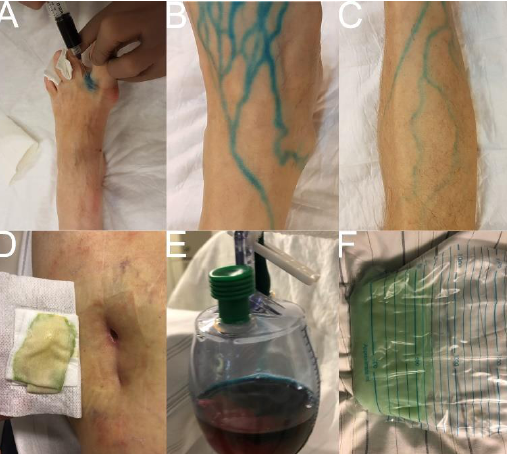
Figure 2. Patent Blue Test. Note: ( A ) subcutaneous injection of a 1:1 Patent Blue V/lidocaine 1% mixture in the first, second, and third interdigital spaces of the foot (1–3 mL each); ( B , C ) visualization of superficial lymph ducts at the lower extremity; ( D ) color change in percutaneous lymphatic fistula; ( E ) color change in lymphocele; ( F ) color change in chylothorax.